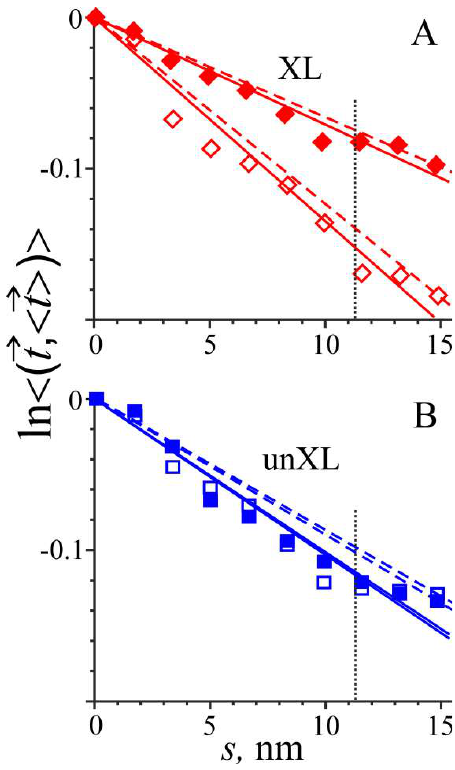
Figure 3. The flexibility plots obtained from MD simulations of cross-linked (XL) ( A ) and uncross-linked (unXL) ( B ) Tpm at 27 °C (closed symbols) and 40 °C (open symbols). Same notations are used for the straight lines as in Figure 2.